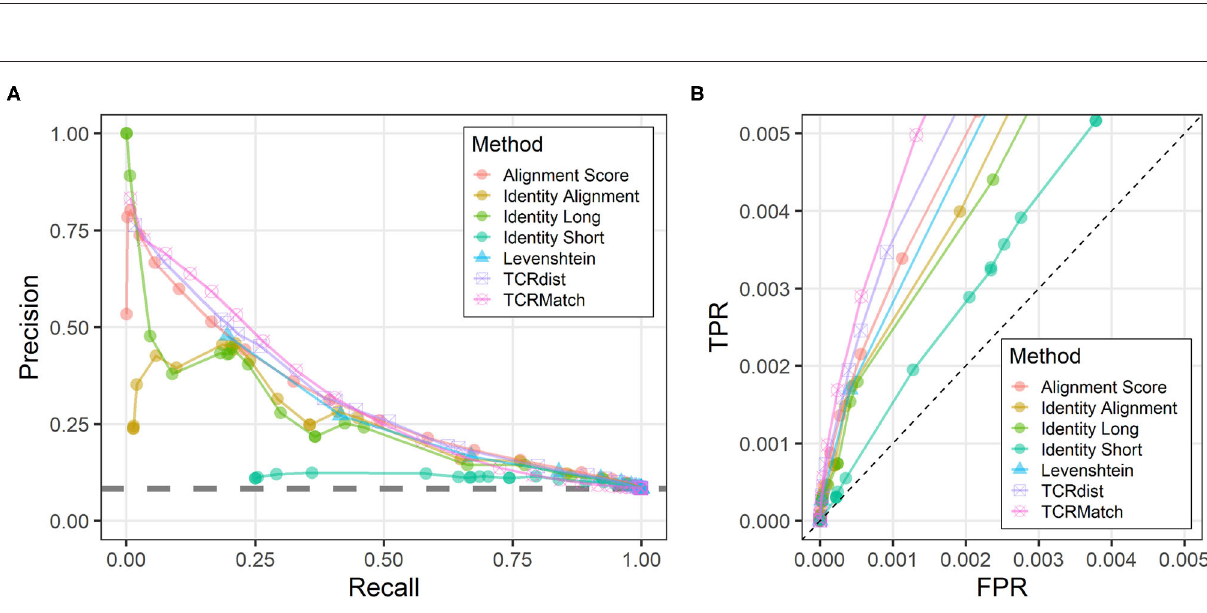
Frontiers in Immunology |